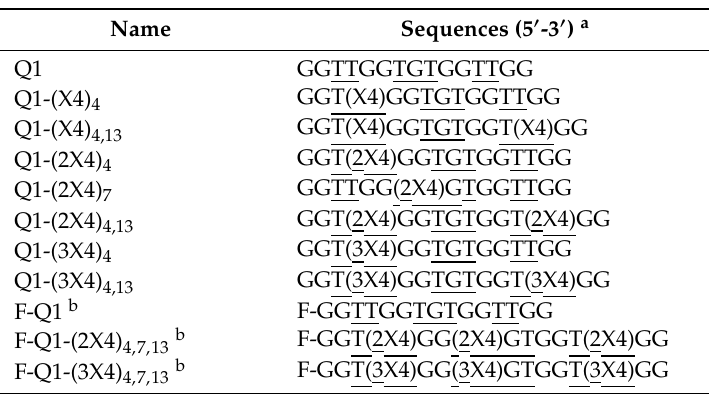
Table 1. DNA sequences used in this